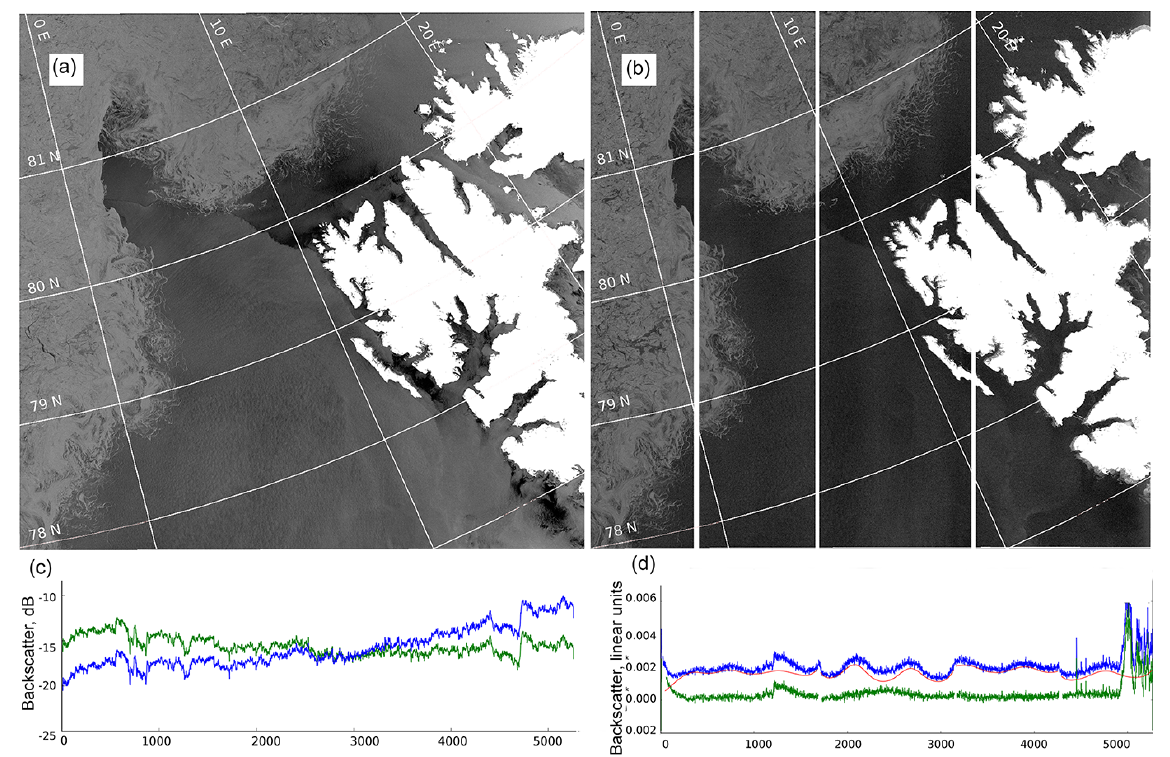
Figure 3. RS2 SCW dual-polarization image taken over Fram Strait on 28 November 2011, including pre-processing. (a) Calibrated image after correction of σ ◦ at 35 ◦ incidence angle using the predefined coefficient for sea ice of − 0.298dB/1 ◦ . (b) Noise-corrected image: beam boundaries are visible due to differences in noise levels between adjacent beams. (c) σ ◦ curves of SAR image across the entire swath: original image (blue) and after angular correction (green). (d) σ ◦ curves of SAR image along the whole swath. The blue curve shows σ ◦ value profile of the raw HV channel image in range direction, the red curve depicts the noise floor level, and the green curve is the result of